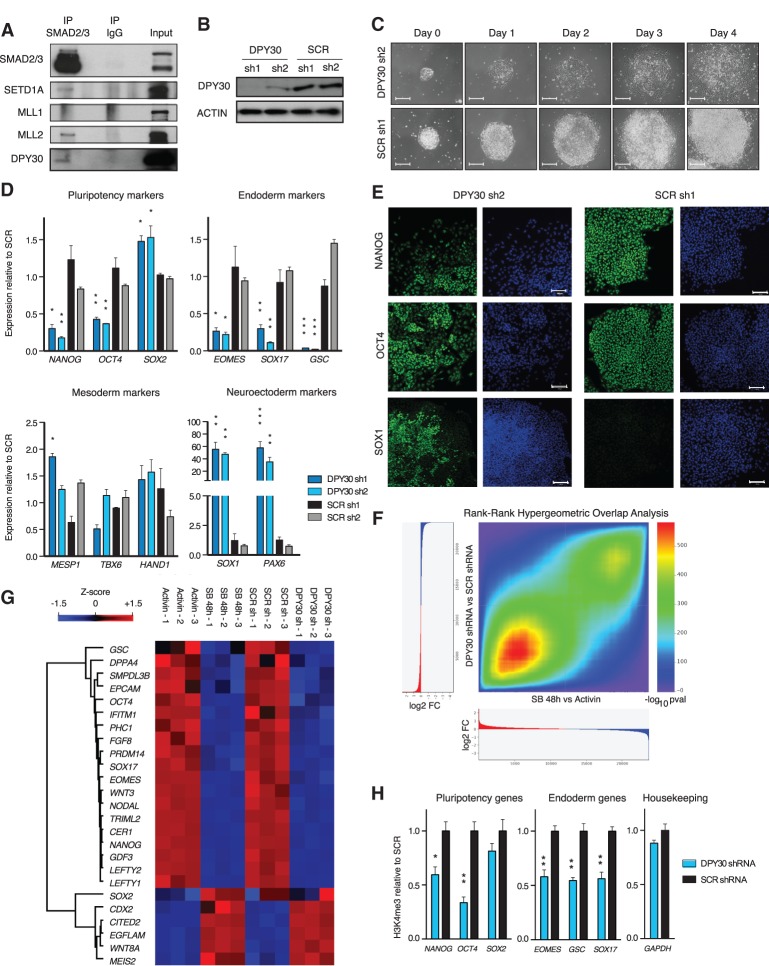
DPY30 is required for H3K4me3 and expression of SMAD2/3 target genes. (A) Western blots of SMAD2/3 or control (IgG) immunoprecipitations (IP) from nuclear extracts of hESCs. Input is 5% of the material used for immunoprecipitation. (B) Western blots in stable DPY30 knockdown (KD) hESC lines or controls (cells expressing a scramble [SCR] shRNA). (C) Phase-contrast images of the same DPY30 knockdown or control hESC colonies after the indicated number of days from the cell split (day 0). Bars, 200 μm. (D) Gene expression qPCR in DPY30 knockdown or control hESCs. Note that SOX2 is both a pluripotency and a neuroectoderm marker. For each gene, significant differences versus both SCR sh1 and SCR sh2 (only the highest P-value is shown) as calculated by one-way ANOVA are reported. (E) Immunofluorescences for the indicated proteins (green) or nuclear staining (DAPI, blue) in DPY30 knockdown or control hESCs. Bars, 100 μm. (F) Rank–rank hypergeometric overlap analysis (RRHO) for genes ranked by their differential expression after DPY30 knockdown or inhibition of Activin/Nodal for 48 h with SB. Color-coded log10
P-values indicate the significance of the overlap between genes in the two conditions, considering hypergeometric tests. (G) Heat map showing changes in gene expression of selected SMAD2/3 target genes after DPY30 knockdown or 48 h of SB. Z-scores were separately calculated for each experiment. (H) ChIP-qPCR for H3K4me3 on SMAD2/3 target genes in hESCs transiently transfected for 48 h with a DPY30 shRNA or a control shRNA. For each gene, significant differences versus SCR as calculated by t-test are reported.